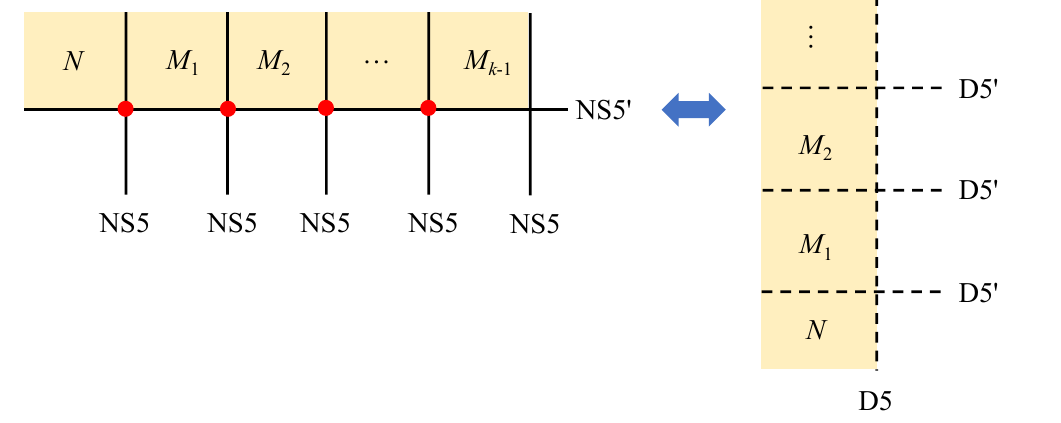
3d ( M ) ( M ) with Neumann b.c. 1 k 1 | − · · · − −